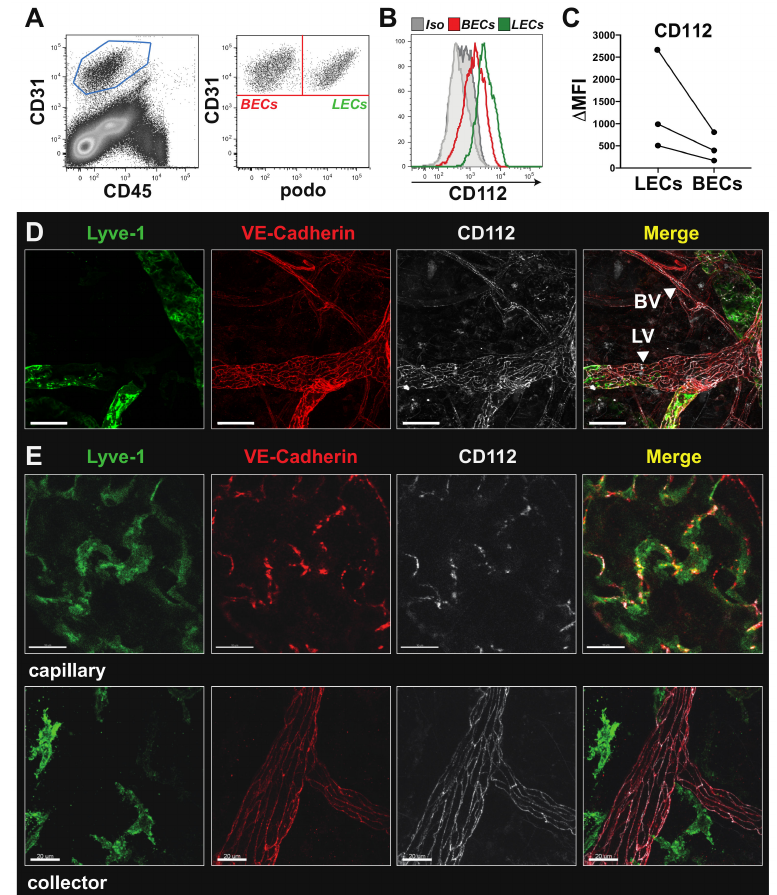
Figure 1. CD112 is expressed by endothelial cells in vivo. ( A , B ) Flow cytometry analysis of mouse ear skin single-cell suspensions. ( A ) Endothelial cells were identified as CD31 + CD45 − cells (left) and further divided into blood endothelial cells (BECs) and lymphatic endothelial cells (LECs) based on podoplanin (podo) expression (right). ( B ) Representative flow cytometry plot showing in vivo expression of CD112 by LECs (green; CD31 + podo + ) and BECs (red; CD31 + podo − ). ( C ) Summary of median fluorescent intensity (MFI) values of CD112 expression on murine LECs and BECs of three experiments. Data points from the same experiment are connected by a line. ( D ) Low magnification confocal images of ear skin whole-mount immunofluorescence staining visualizing CD112 expression (white) by lymphatic vessels (LVs) and blood vessels (BVs), indicated by white arrow heads. Scale bar: 50 µ m. ( E ) High magnification confocal images revealed a button-like expression pattern for CD112 (white) in lymphatic capillaries (LYVE-1 + /VE-cadherin + upper panel), respectively, and a zipper-like expression pattern in lymphatic collectors (LYVE-1 − /VE-cadherin + lower panel). Scale bar: 20 µ